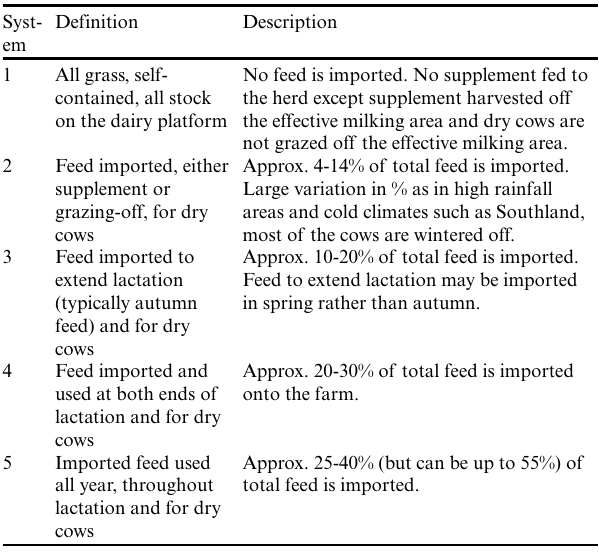
Table 1 . DairyNZ classification of farm systems (DairyNZ